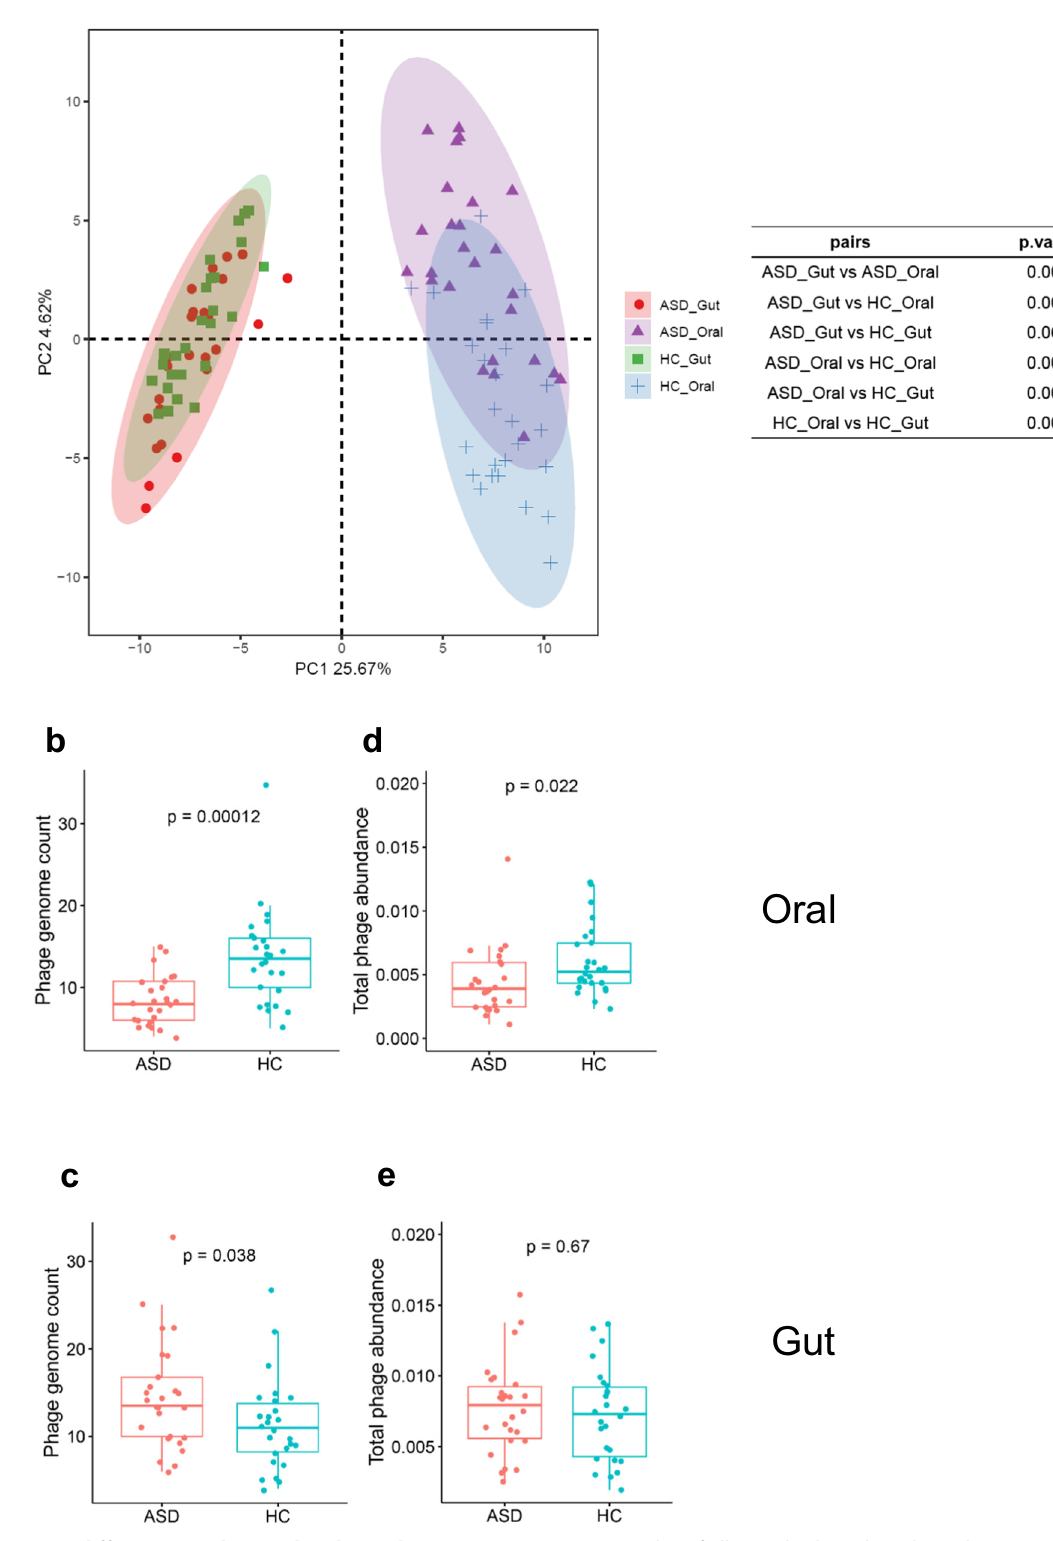
Fig. 3 The ASD vs. HC differences in their oral and gut phage communities. a PCA plot of all samples based on their phage gene contents. The distances within habits are tested by PERMANOVA. b , c The difference between ASD and HC subjects in the richness of phages in oral ( b ) and fecal ( c ) samples tested by Mann – Whitney U test. d , e The difference between ASD and HC subjects in the total relative abundance of phages in oral ( d ) and gut ( e ) microbiota tested by Mann – Whitney U test. In Box – Whisker plots, the middle horizontal line refers to the median value, and the width of the box is the interquartile range (IQR) with a 1.5 IQR whisker